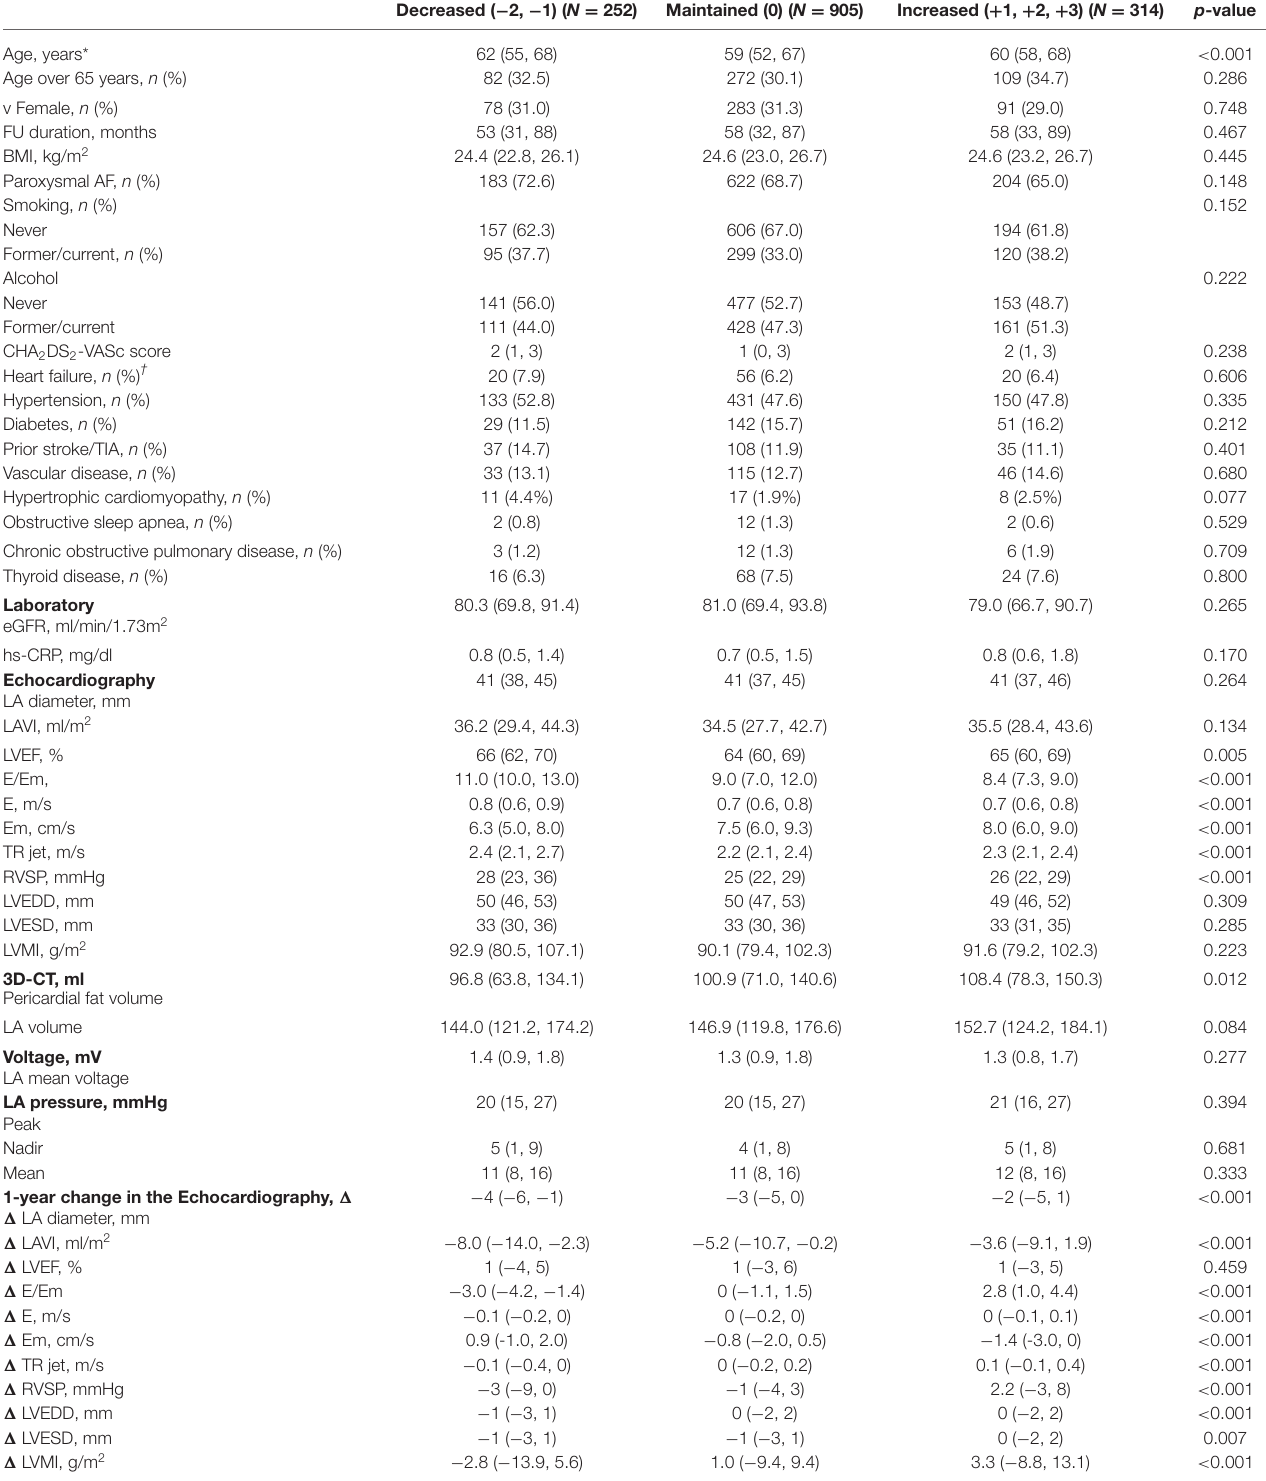
TABLE 2 | Baseline characteristics according to the change in the H 2 FPEF scores in AF patients with a normal LVEF, 1-year after the atrial fibrillation catheter ablation